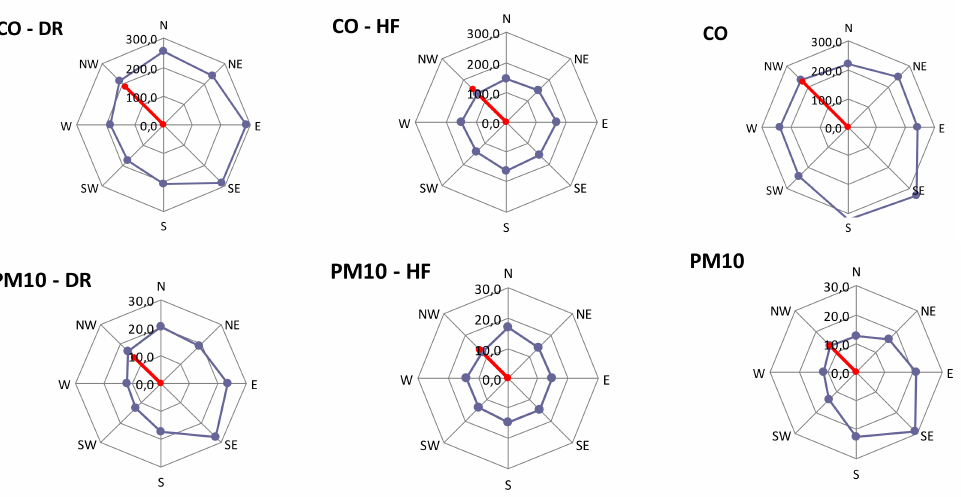
Figure A2. Average levels of CO and PM 10 vs. wind direction measured at the Stary Wiec station during drilling (DR), hydrofracturing (HF), and for the remaining period of measurements. Con- centration units are in parts per billion (ppb), except for PM 10 ( µ g/m 3 ). The red bars indicate the airmass coming directly from the area of the